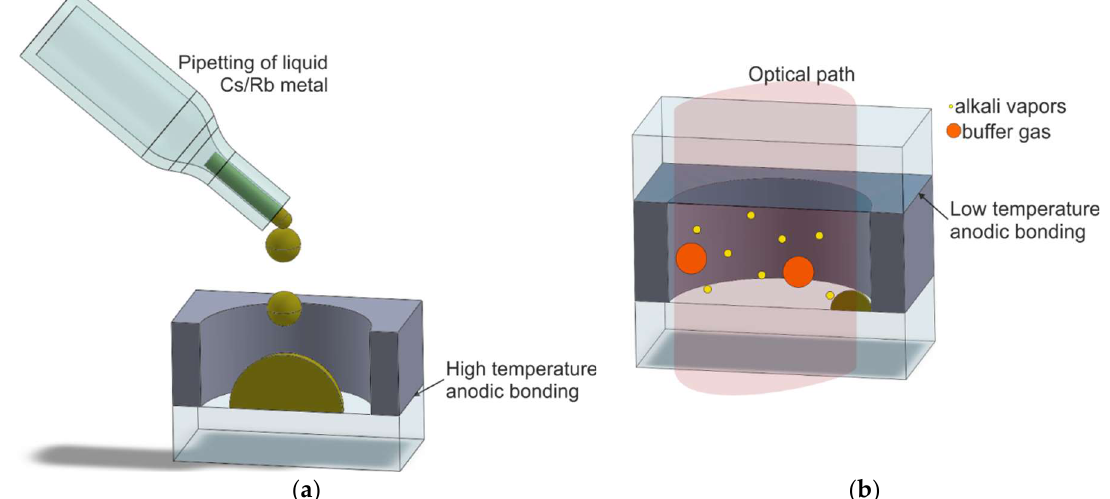
Figure 3. Fabrication process with direct alkali metal introduction utilizing pipetting: ( a ) liquid metal pipetting to silicon–glass preform, ( b ) cross section of the cell.